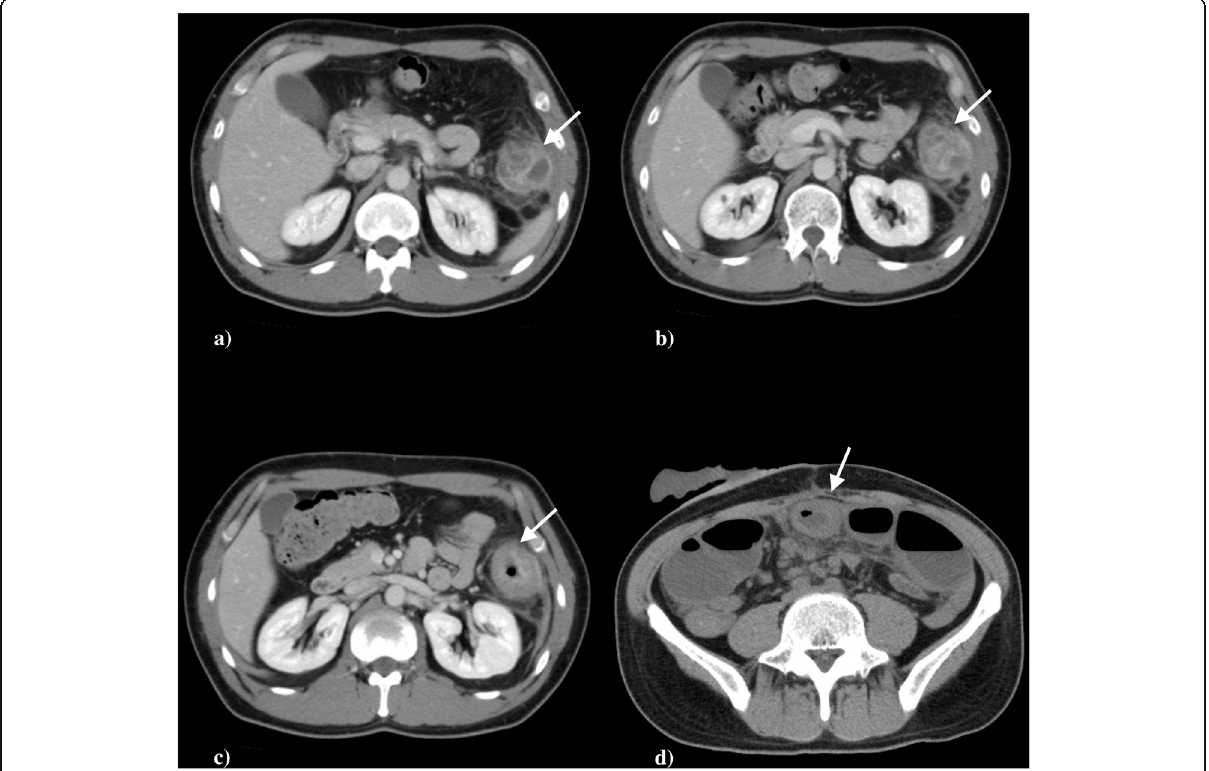
Fig. 1 a – d Enhanced CT scan of abdomen showed highly enhanced thickened wall of the colon in the splenic flexure